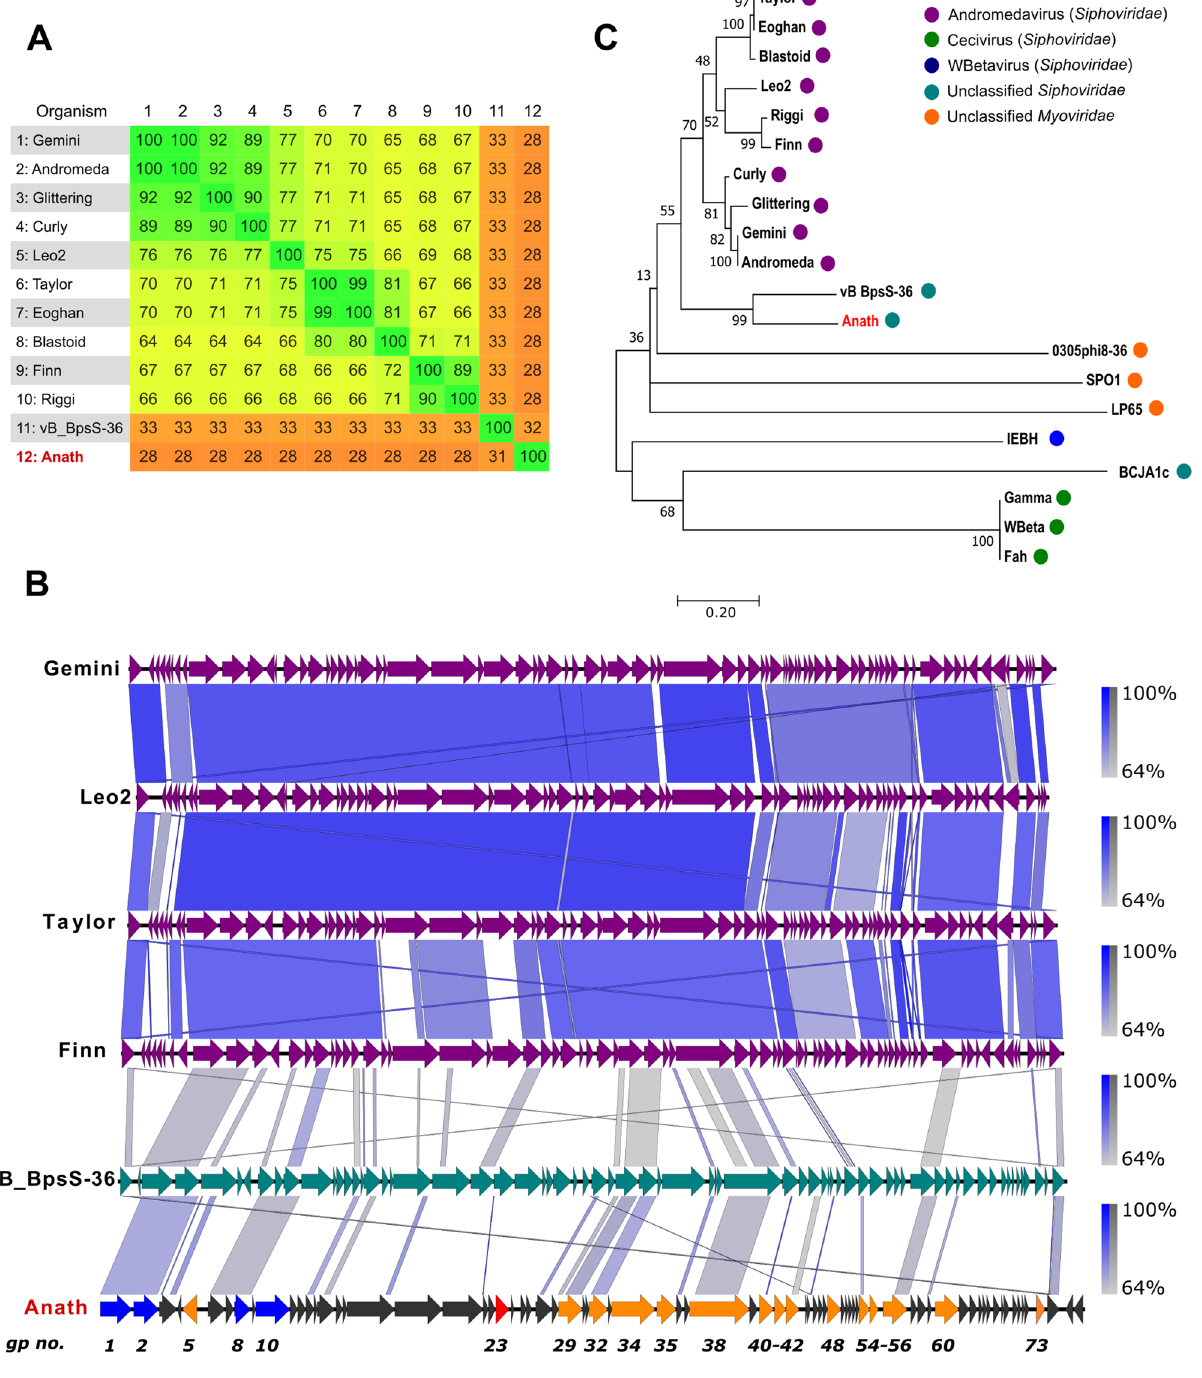
Figure 3. Comparative genomics and phylogenomic affiliation of phage Anath with other Bacillus phages. ( A ) Heat-map of fragmented multiple alignment (tBLASTx) constructed in Gegenees version 2.2.1 (accurate mode: fragment size = 200 bp, sliding-step size = 100 bp) between Anath (bold) and the 11 phages hits from BLASTn search. ( B ) Genome comparison of Anath (bottom) and selected representatives (Gemini, Leo2, Taylor, Finn and vB_BpsB-36), using the Easyfig genome visualisation tool in BLASTn mode (version 2.2.3). Nucleotide similarity at different regions between genomes is given in percentages (right bar) ( C ) Maximum- likelihood phylogram, based on the terminase nucleotide sequence of Anath (highlighted as red), vB_BpsS-36 the Andromedavirus genus and eight outliers. The selected phages are labelled according to their taxonomy classification in GenBank (right bar). The percentage of trees in which the associated taxa clustered together is shown next to the branches. A bootstrap value of 100 was used in the